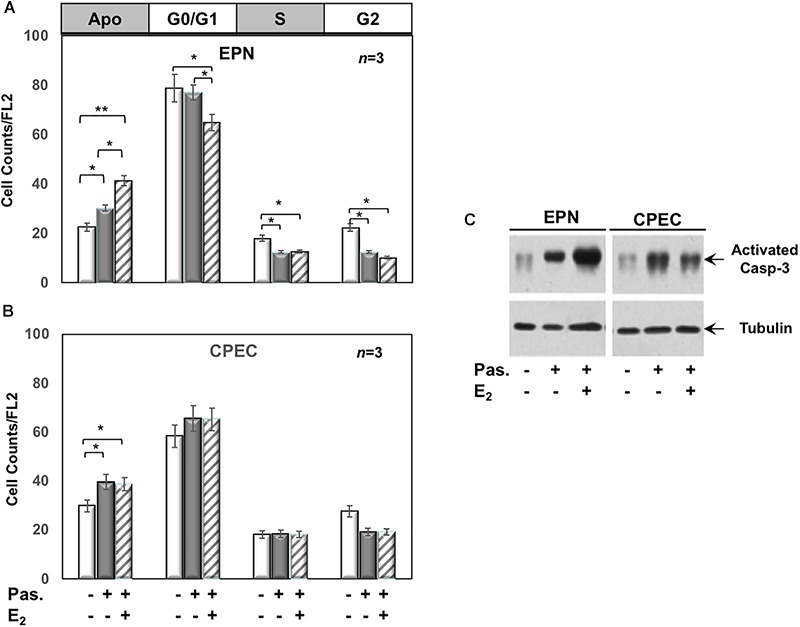
Effect of both estradiol and pasireotide on cell cycle. Flow cytometry analysis of propidium iodide-labelled EPN (A) or CPEC (B) was done, as described in Methods. In panel (A,B), quiescent cells were left under untreated or treated for 24 h with 0,1 μM pasireotide, in the absence or presence of 20 nM estradiol. Histograms in panel (A,B) represent the % counts/FL2 areas of labeled cells in the different cell cycle phases after the indicated treatments. Means and SEMs are shown. n represents the number of experiments. ∗p < 0,05; ∗∗p < 0,01. In panel (C), quiescent EPN (left section) or CPEC (right section) cells were left untreated or treated for 24 h with 0,1 μM pasireotide, in the absence or presence of 20 nM estradiol. Lysate proteins were separated by SDS-PAGE, transferred to PDVF membrane and filters were then analyzed by Western blot, using the anti-activated caspase 3 or anti-tubulin antibodies.